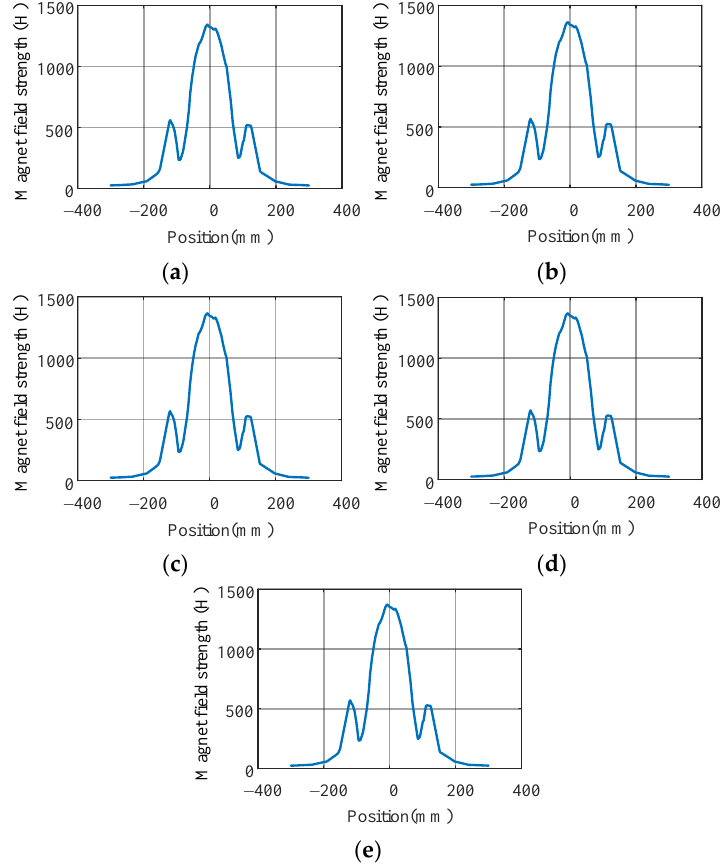
Figure A4. Magnetic field strength curves with different relative permeabilities of MnZn ferrite. ( a ) 1200. ( b ) 2500. ( c ) 3000. ( d ) 5000. ( e ) 7500.